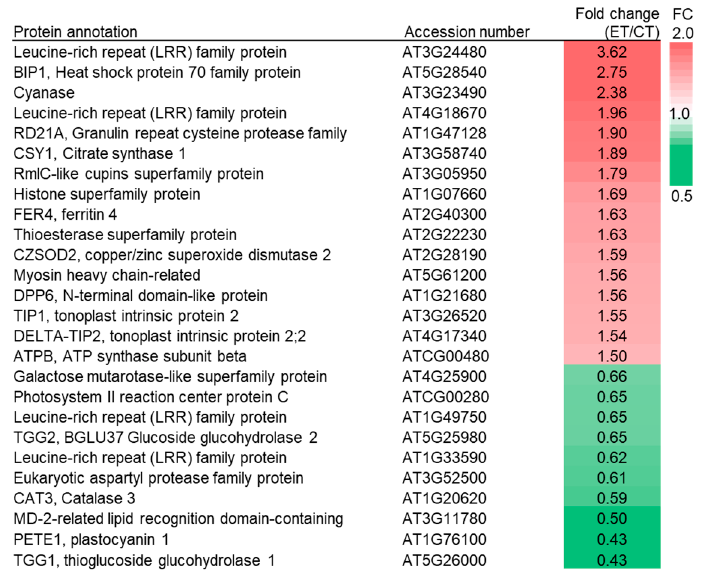
Figure 5. Differential accumulation of Arabidopsis proteins in frass from T. ni larvae reared at control versus elevated temperature. T. ni larvae were reared on WT Arabidopsis plants under CT or ET conditions as described in the main text. Arabidopsis proteins excreted in caterpillar frass were identified and quantified using a tandem-mass tag shotgun proteomics approach (see Methods). Listed are all Arabidopsis proteins showing increased (red) or decreased (green) abundance under ET compared to CT conditions (1.5-fold cutoff for ET/CT).